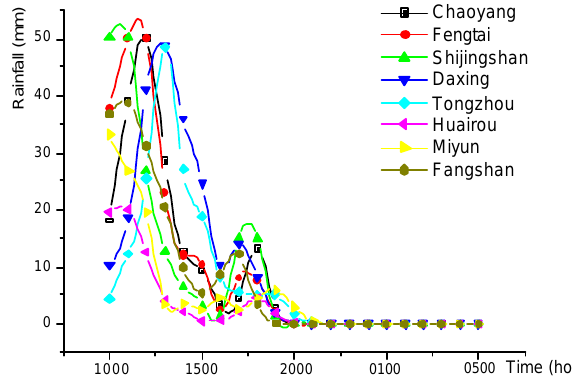
Fig. 7. Hourly rainfall of eight mainly affected districts between 09:00UTC and 21:00UTC on 21 st -22 nd July 2012.